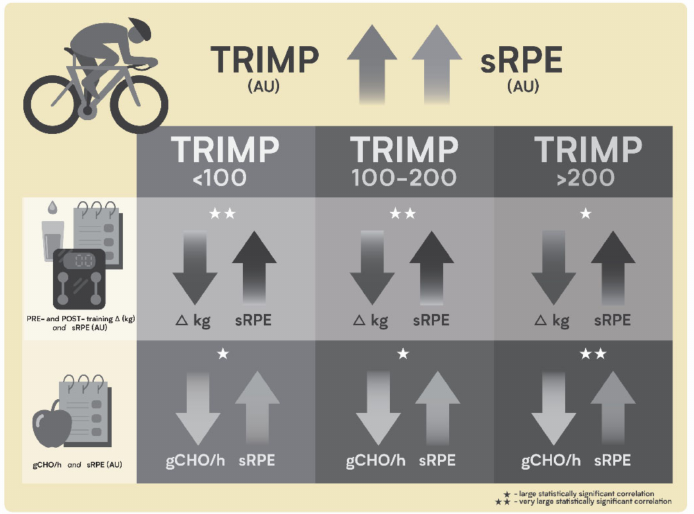
Figure 5. Graphical representation of the inter-relationships between training load markers, fluid balance and carbohydrate supply during exercise. Increased fluid loss (negative ∆ ) as well as lower or no carbohydrate consumption is related to an increased fatigue perception (sRPE) independently from training load category